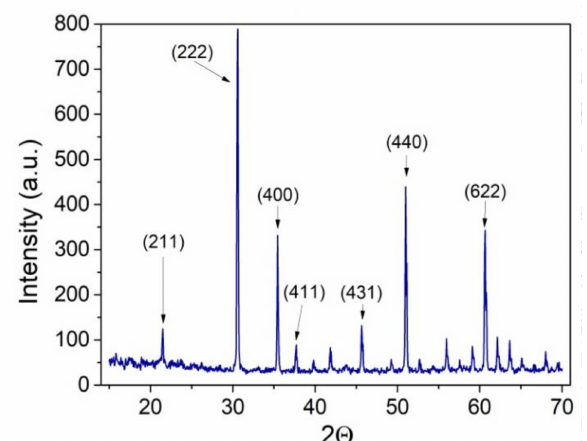
Figure 2. Typical XRD pattern of an In 2 O 3 sample synthesized at 500 ◦